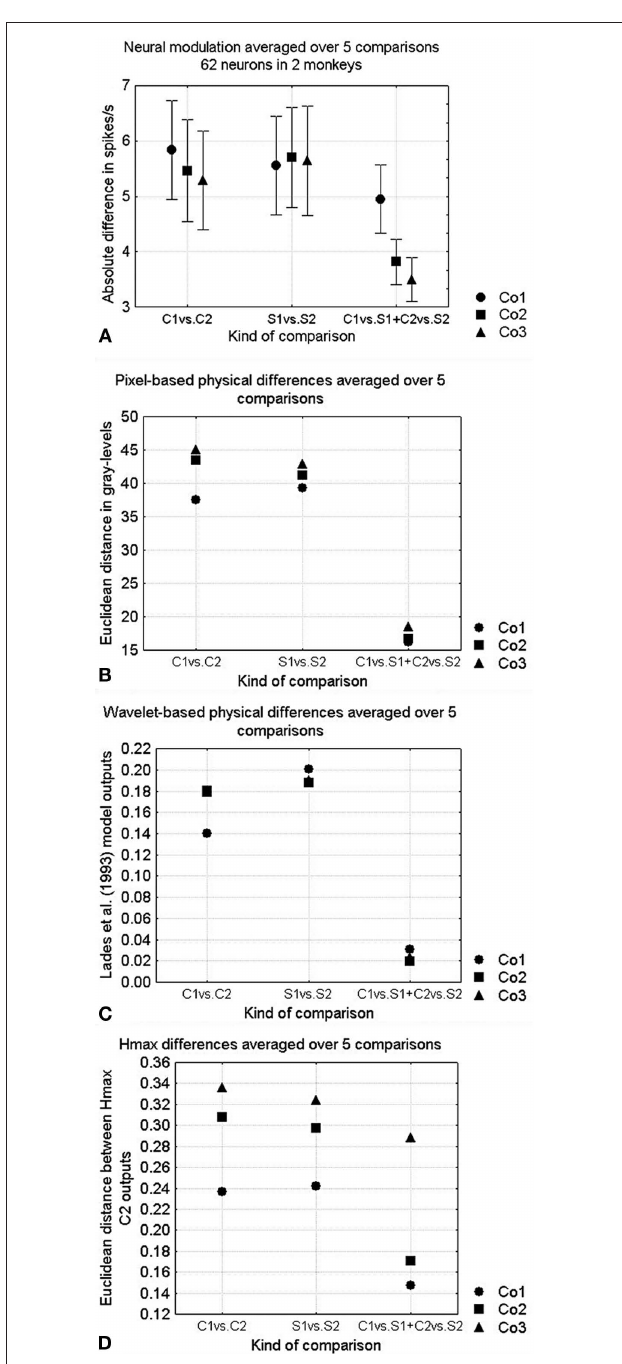
Figure 3 | (A) Neural sensitivities for the different kinds of shape differences. The kind of shape difference is presented on the abscissa using the column notations of Figure 1 (respectively shape differences within curved shapes, shape differences within straight shapes and curved versus straight contours) while the complexity of the stimuli is represented by circles, squares, and triangles for shapes from respectively Co1, Co2, and Co3. Curved versus straight comparisons were first averaged within the rows (according to the formula (|C1 − S1| + |C2 − S2|)/2), thus also their standard errors are on five data points. Vertical bars denote standard errors. (B) Pixel-based dissimilarities, (C) Lades model dissimilarities, and (D) Euclidean distance between HMAX